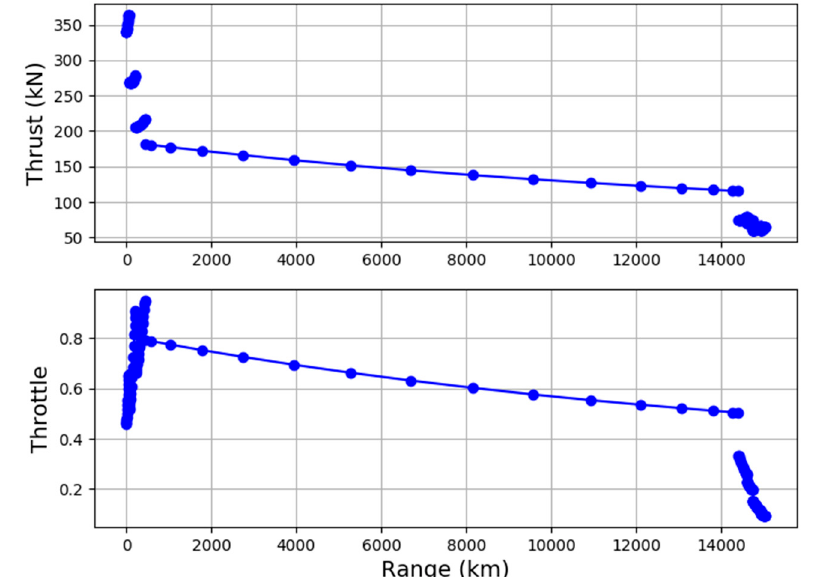
Figure A3. Thrust and throttle settings of SE²A-LR.